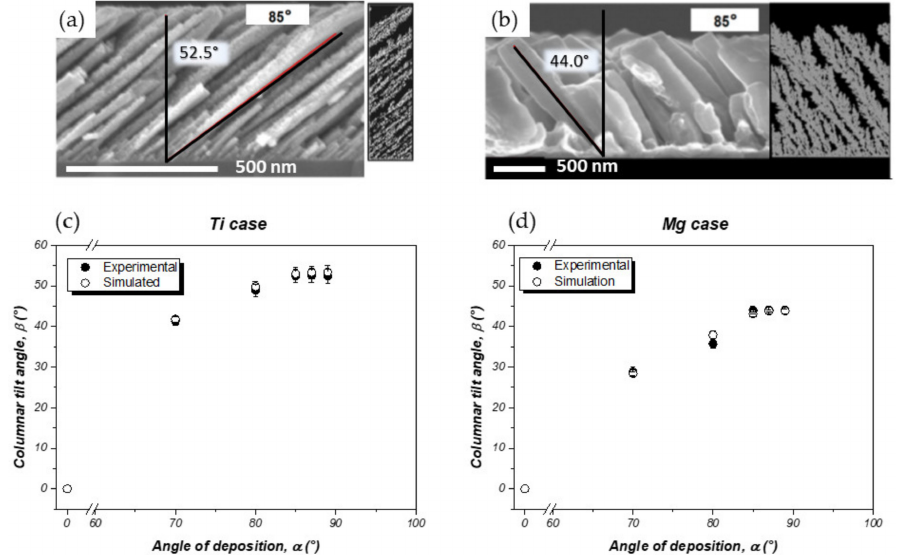
Figure 5. SEM (scanning electron microscopy) cross-sectional view with the corresponding simulation of: ( a ) Ti and ( b ) Mg columnar films deposited with α = 85 ◦ . Evolution of the columnar tilt angle ( β ) as a function of the angle of deposition ( α ) for ( c ) Ti and ( d ) Mg nano-sculpted thin films. The error bars were estimated by taking the tilt average over 20 columns (adapted from [50] with permission from Elsevier, 2017, and from [32], MDPI,